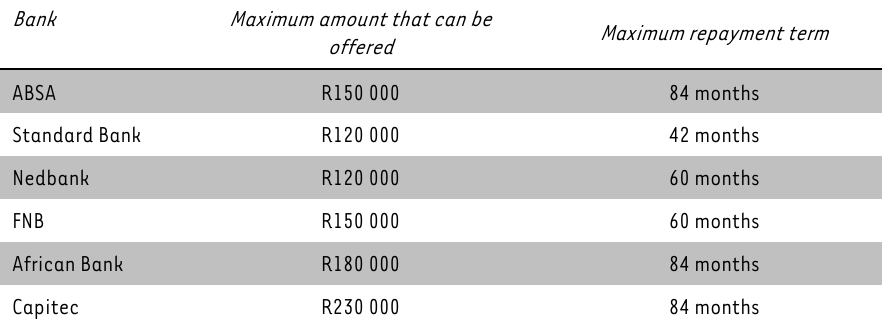
TABLE 1: Amounts of unsecured loans and repayment terms Bank Maximum amount that can be